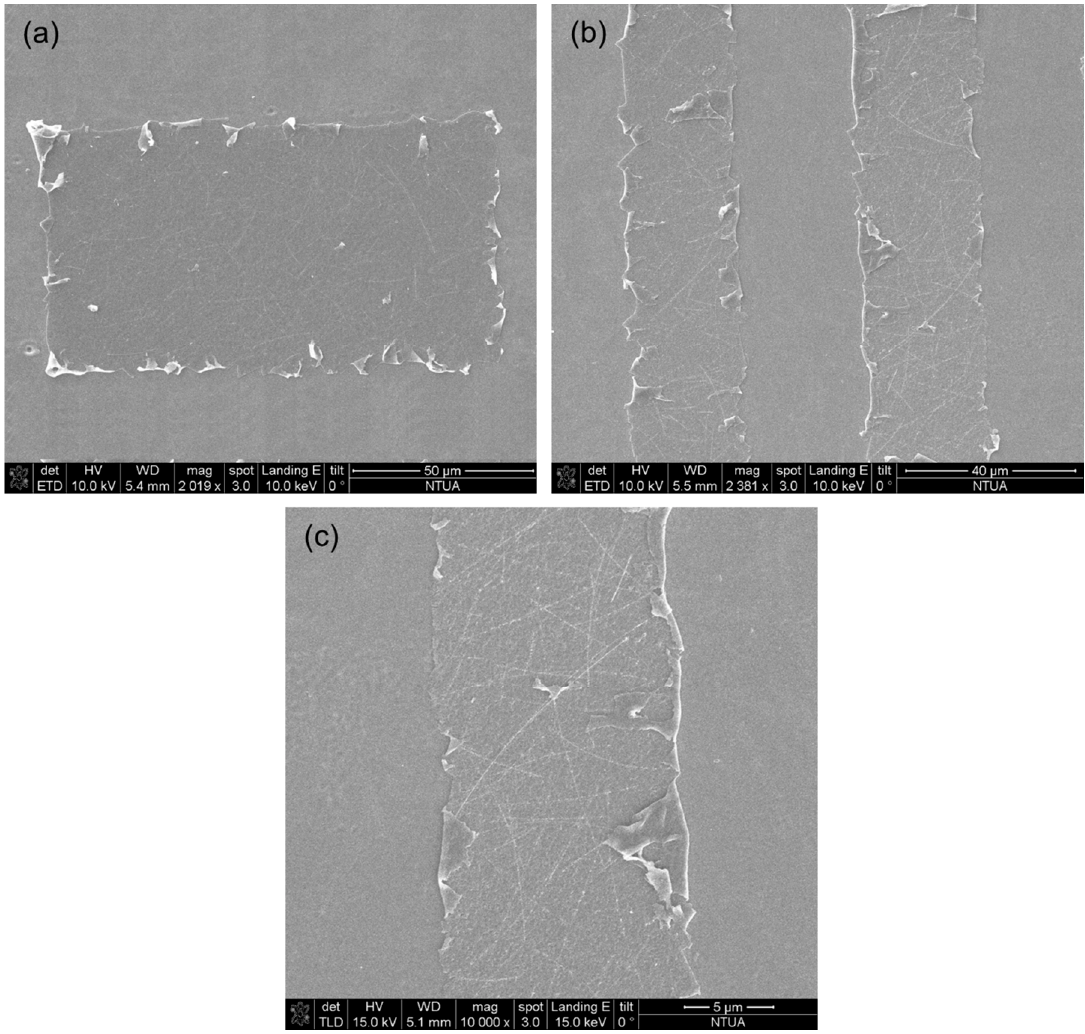
Figure 5. SEM micrographs of printed pixels of high aspect ratio 1:10 rectangular Ag NWs. ( a ) close view of a single pixel. ( b ) two rectangular pixels transferred with a 1:1 ratio of width:spacing. ( c ) Smallest feature size achieved with lateral dimension of 12 μ m.